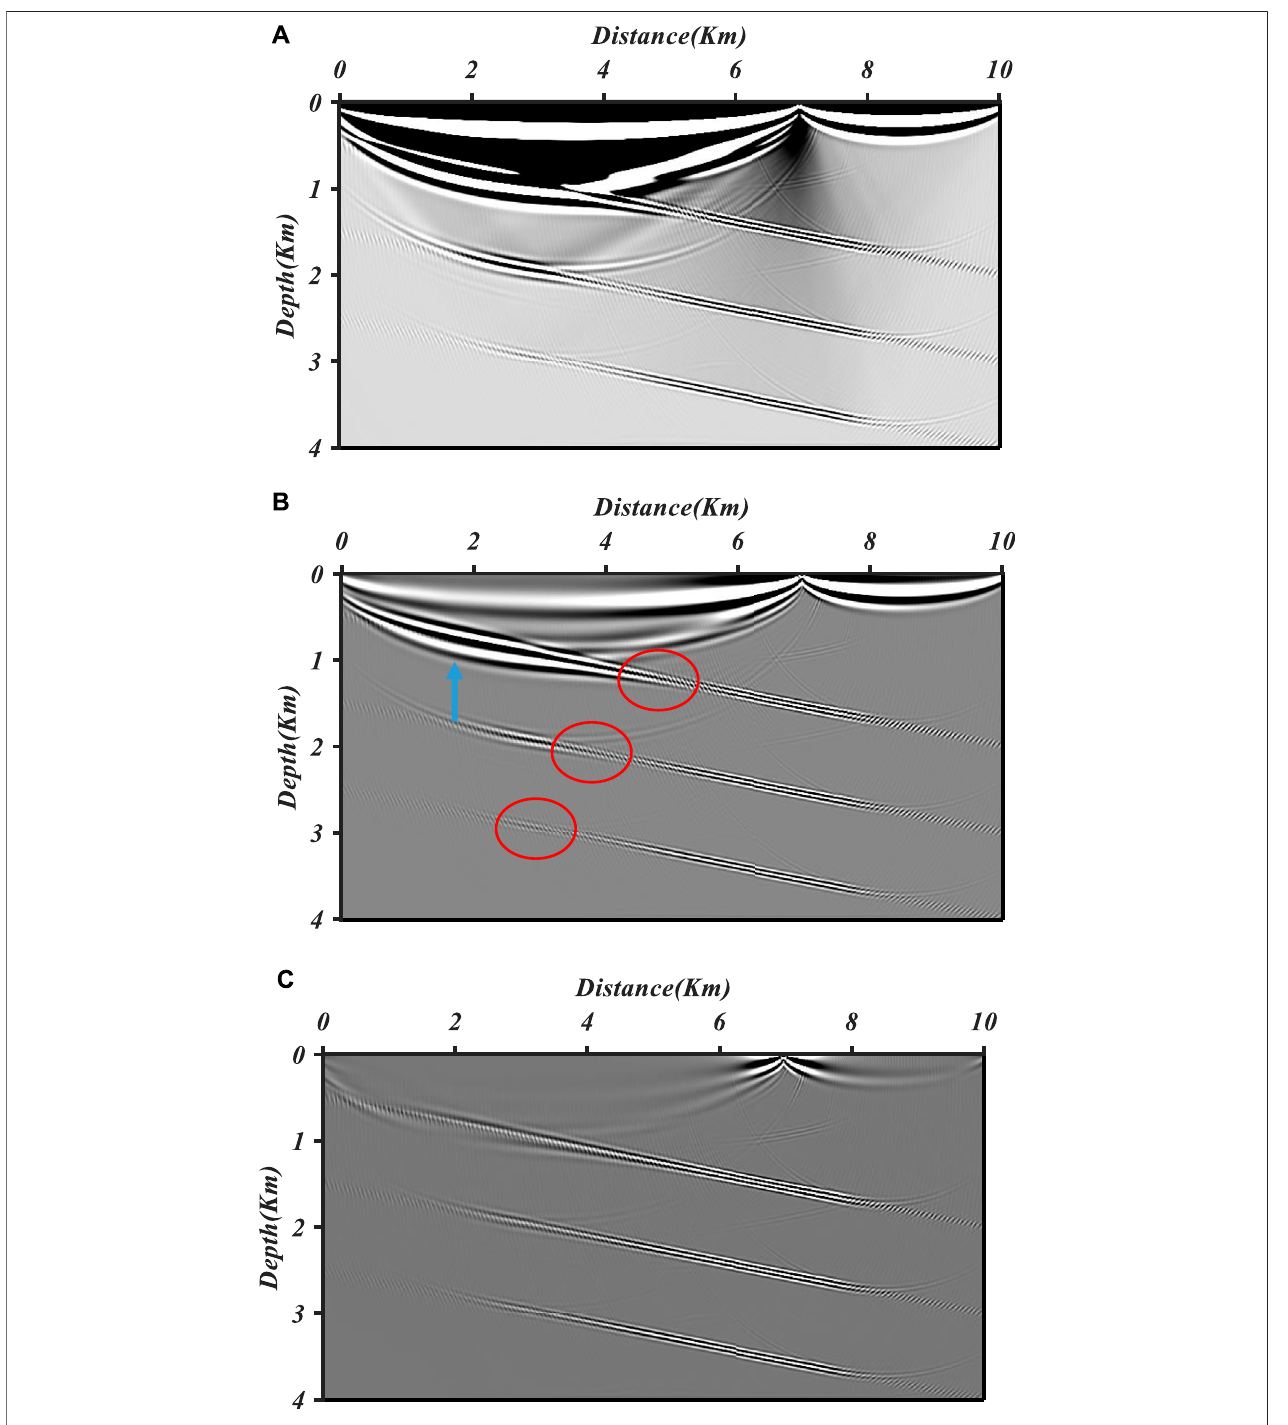
FIGURE 12 | PP migrated images of the four-layer inclined model by the scalar imaging condition (A) , the scalar imaging condition with a Laplace fi lter (B) , and the scalar imaging condition with a pseudo-Laplace fi lter (C) . The backscattering noise (marked by the red arrow) has been effectively suppressed in PP images by scalar imaging conditions with a Laplace fi lter and a pseudo-Laplace fi lter. Furthermore, the polarity reversal (marked by the red circle) has been corrected in the PP image by the scalar imaging condition with a pseudo-Laplace fi lter.